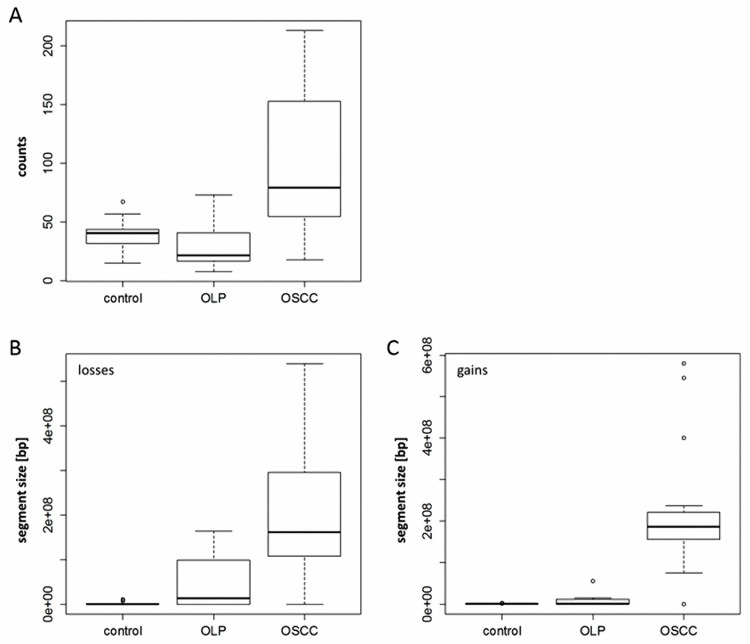
Chromosomal alterations in normal oral squamous cells (control), oral lichen planus (OLP) and oral squamous cell carcinoma (OSCC).The absolute number (counts) of detected alterations in the individual groups (A), as well as the size of losses (B) and gains (C), are presented as box plots indicating quartiles and medians.